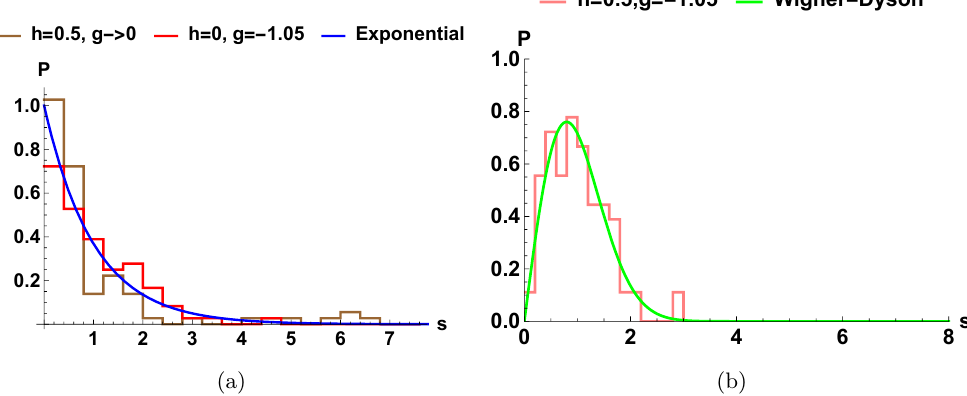
Figure 24 . Level spacings for the mixed field Ising model with N = 10 at three different points in parameter space. (a) compares two parameter choices, one of which corresponds to a free model and other to an interacting integrable model, to the exponential distribution, while (b) shows a choice of parameters in the chaotic regime compared to the Wigner-Dyson